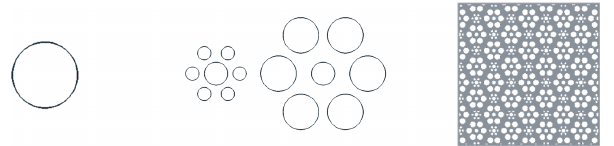
Figure 10. Evolution of the third